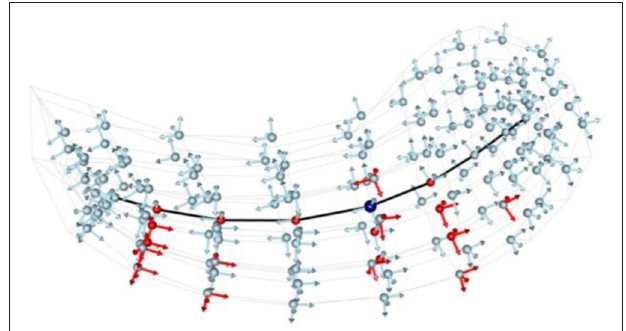
FIGURE 11 | Hypothesis tests on hippocampi of Parkinson’s Disease vs. Control Group. Light-blue and red arrows indicate fitted frames representing non-significant and significant orientations, respectively. Light-blue and red spheres depict non-significant and significant positions. The dark-blue bullet is the center point. The black curve is the spine. Results are after p -value adjustment by Benjamini-Hochberg with False Discovery Rate (FDR) equal to